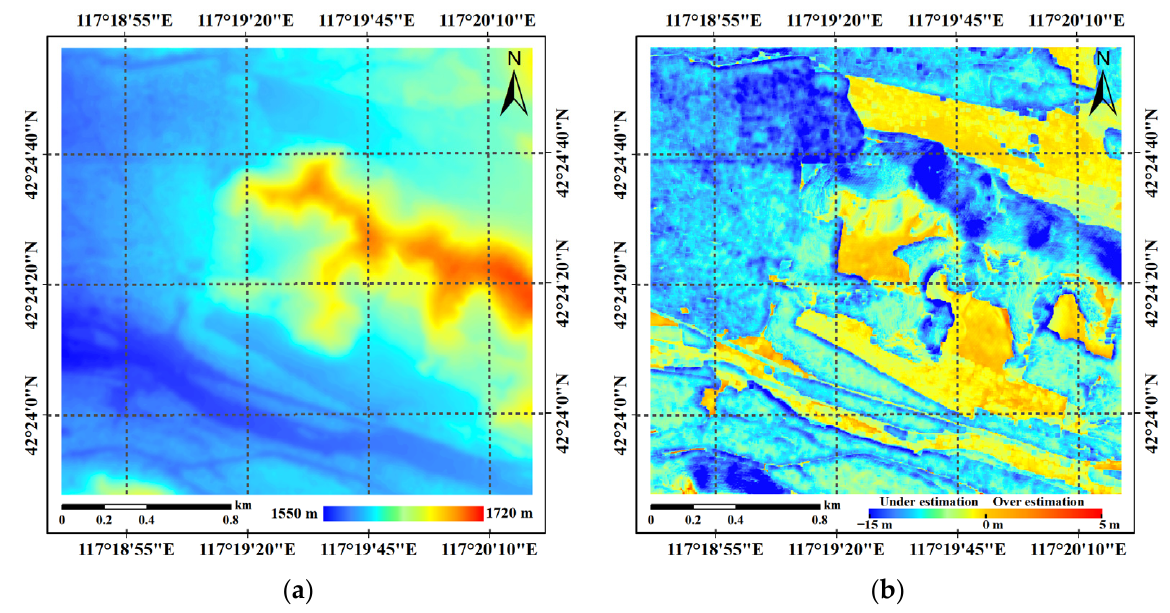
Figure 9. Histograms of the DTM difference ( DTM P-band minus DTM LiDAR ).